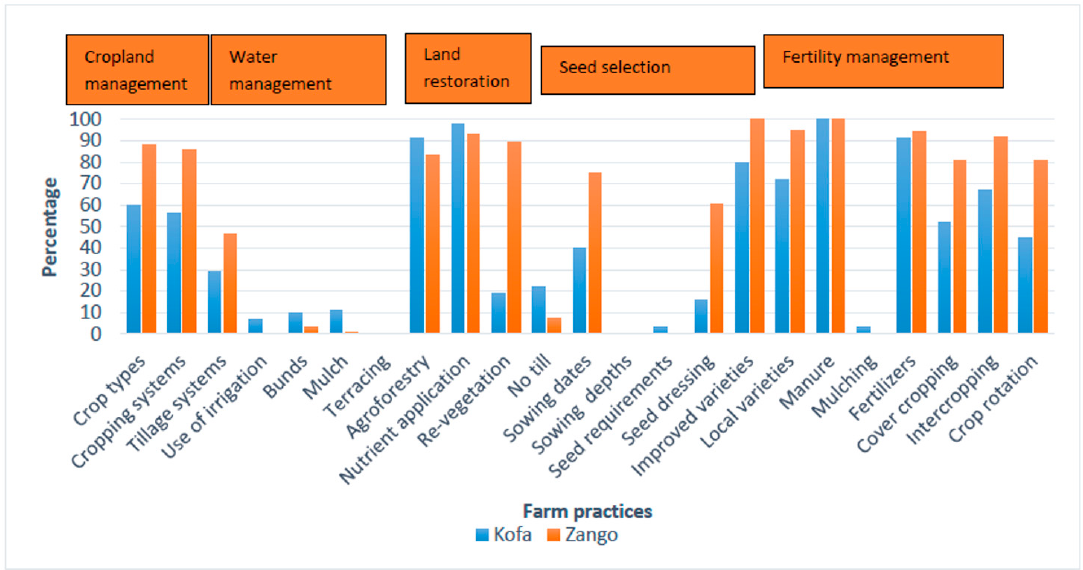
Figure 7. Current farm practices employed in Zango (n = 120) and Kofa (n = 100) based on a baseline study.